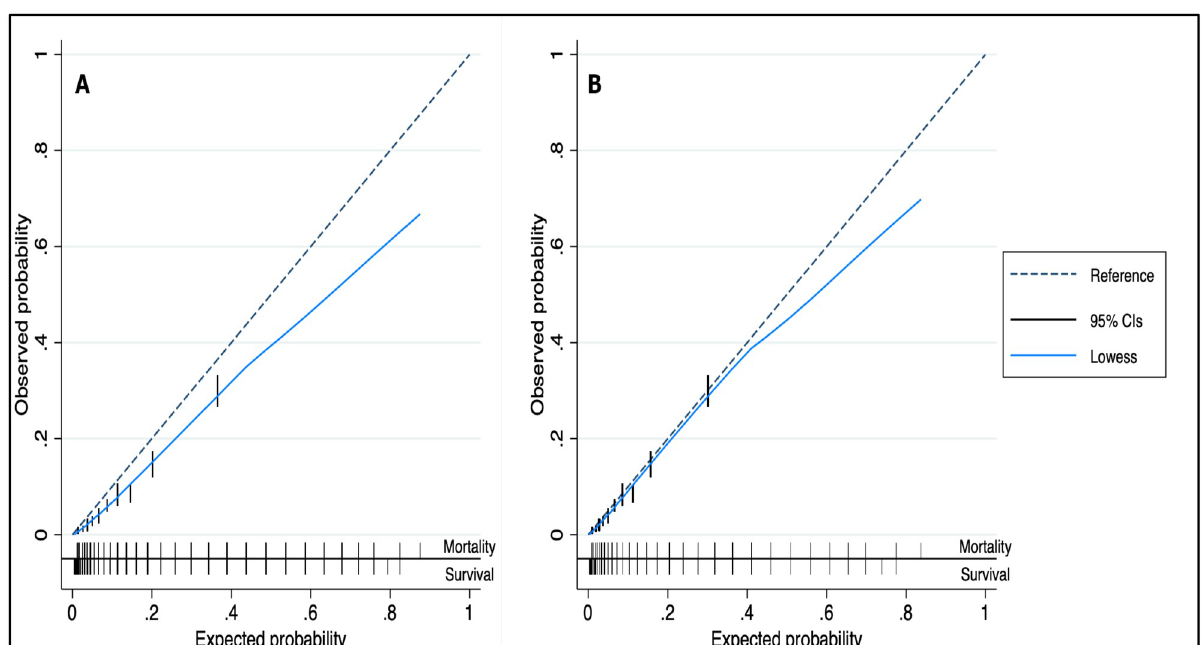
Fig 3. Calibration curve on validation cohort of OPERA points model before and after recalibration. (A) before recalibration, (B) after recalibration. Reference line, 95% confidence interval, lowess smoothing curve, and the distribution of mortality and survival against predicted